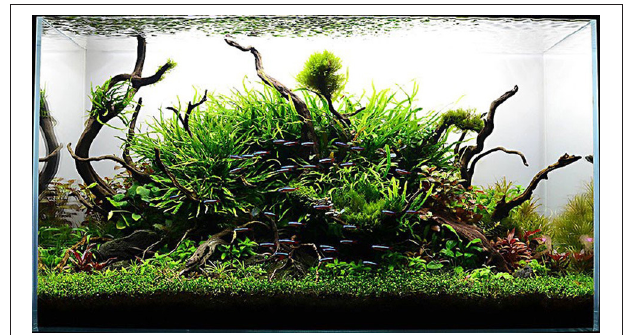
FIGURE 2 | Houston’s Hiep Hong’s “Jungle Style” 54 gallon aquarium, Aqueous Reflection , placed 116th at the 2017 International Aquatic Plants Layout Contest (IAPLC) (Brenner, 2017). He used specific species and his knowledge of them to create a living piece of art. Photo reproduced with the permission of the copyright holder [Hiep